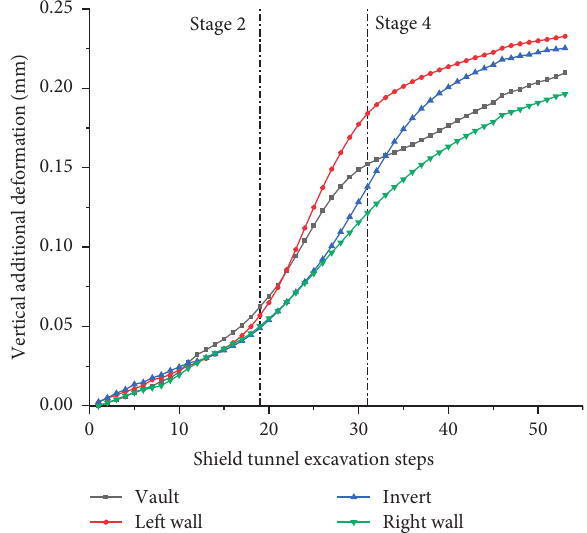
Figure 25: Support structure of the vertical additional displacement curve.